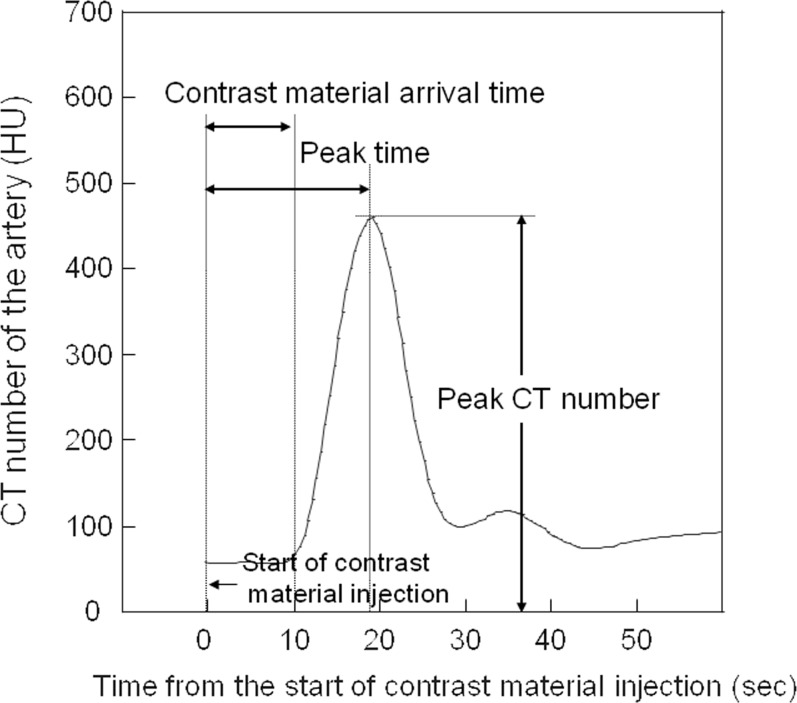
Time curve of arterial enhancement of the aorta.We defined the arrival time (AT) of the contrast material as the point 2 sec before the attenuation value was 10 HU greater than on unenhanced CT scans. The peak time (PT) was defined as the time between the start of contrast material injection and the time at which the arterial CT number peaked.